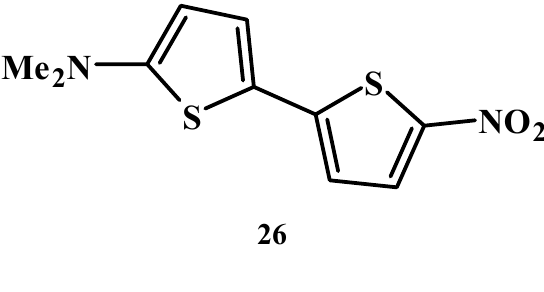
Figure 16. The molecular structure of donor-acceptor-substituted